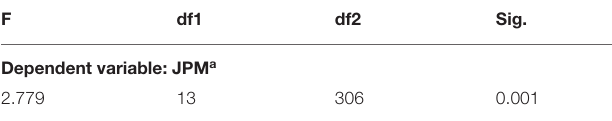
TABLE 4 | Levene’s test of equality of error